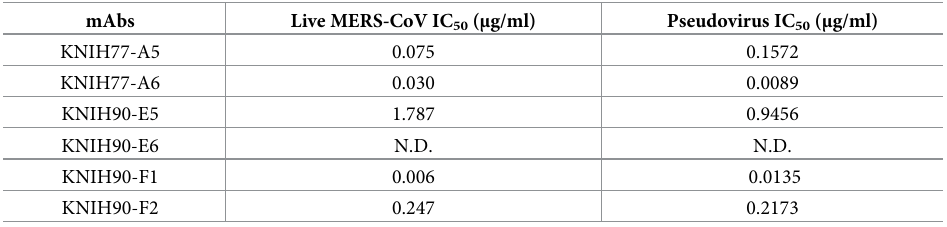
Table 1. Neutralization activities of RBD-specific mAbs to MERS-CoV EMC